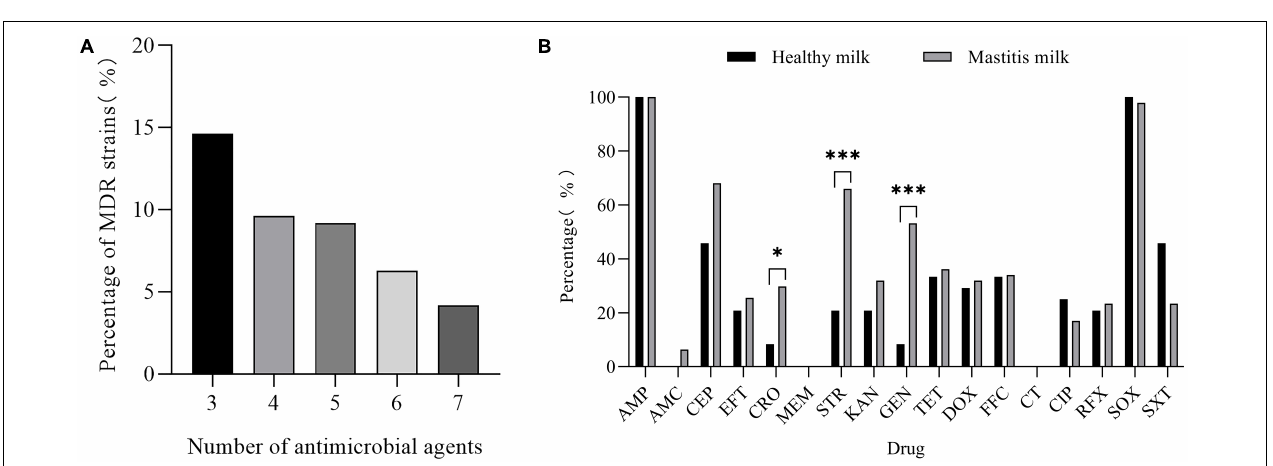
FIGURE 6 | (A) Proportion of multidrug-resistant (MDR) K. pneumoniae resistant to different amounts of antibiotics. (B) Resistance rate of healthy milk and mastitis milk [milk from CM and subclinical mastitis (SCM) cows] to 17 antimicrobials. “ ∗ ” indicates p < 0.05 and “ ∗ ” indicates p <